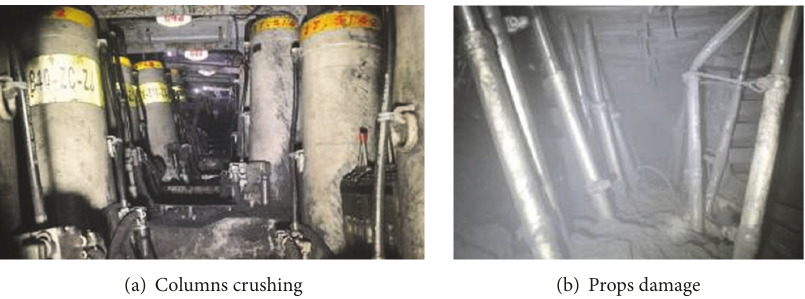
Figure 2: Appearance of strong mining pressure in the ultrathick coal seams.